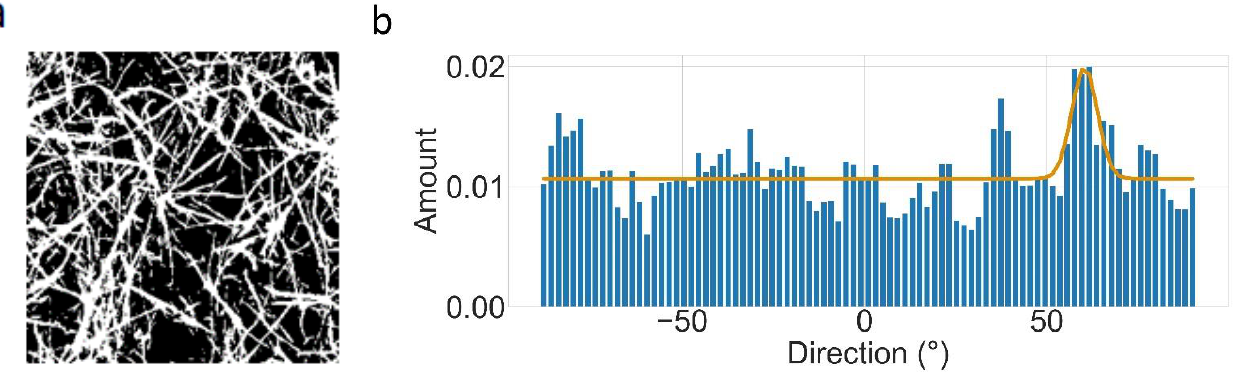
Figure 3. ( a ) Exemplary skeletonized image of a 2 mg/mL collagen network. ( b ): Angle distribution of ( a ). The degree values are given in the mathematical sense, i.e., 0° is pointing to the right. The fit is a Gaussian function, provided by ImageJ.